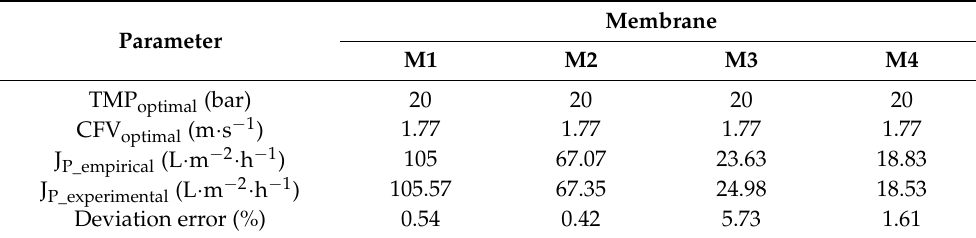
Table 4. Optimal TMP and CFV for maximising J P . Comparison between empirical and experimen- tal